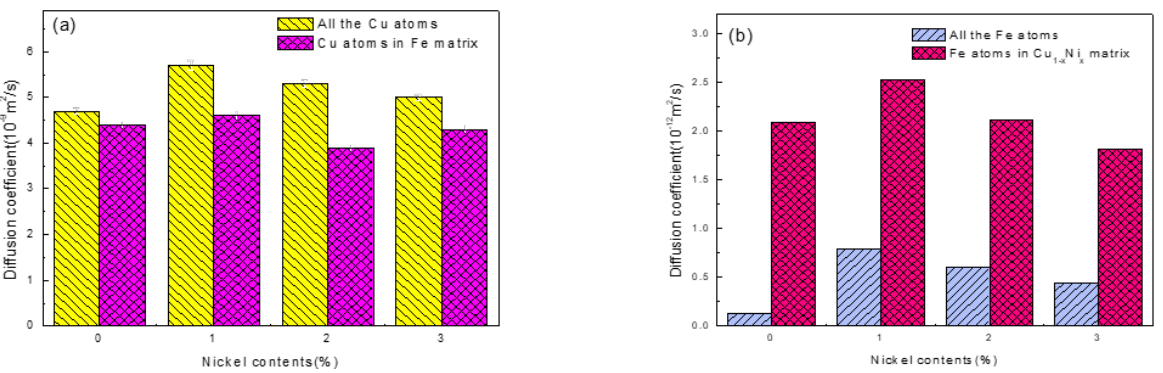
Figure 6. Diffusion coefficients for: ( a ) all Cu atoms and Cu atoms in the Fe matrix at 1523 K versus the nickel atom concentration; ( b ) all Fe atoms and Fe atoms in the Cu 1 − x -Ni x matrix at 1523 K versus the nickel atom